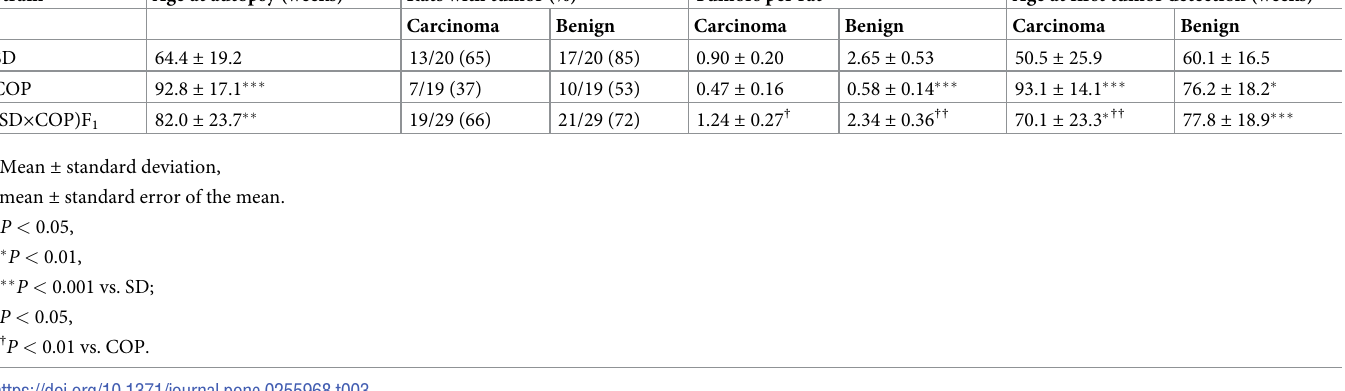
Table 3. Crude analysis of mammary tumor development in SD, COP and (SD × COP)F 1 strains.